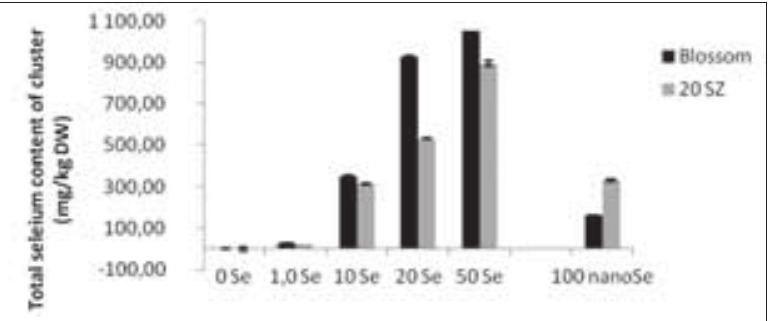
Fig. 4: Total selenium content of Blossom and 20SZ Arundo donax L. ecotypes treated with 0; 1; 10; 20; 50 mg L -1 sodium-selenate or red elemental nanoselenium suspension (100 mg L -1 )